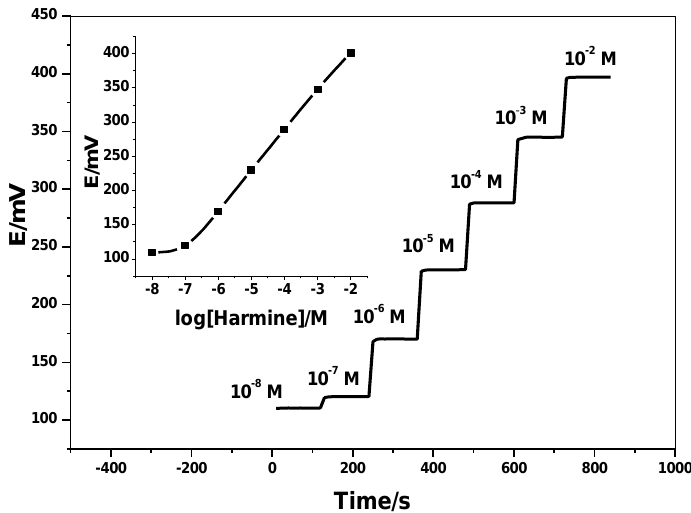
Figure 4. Time response of C/PEDOT:PSS/harmine-ISE (inset: the calibration plot of the sensor). The effect of pH on the potentiometric response of C/PEDOT:PSS/harmine-ISE